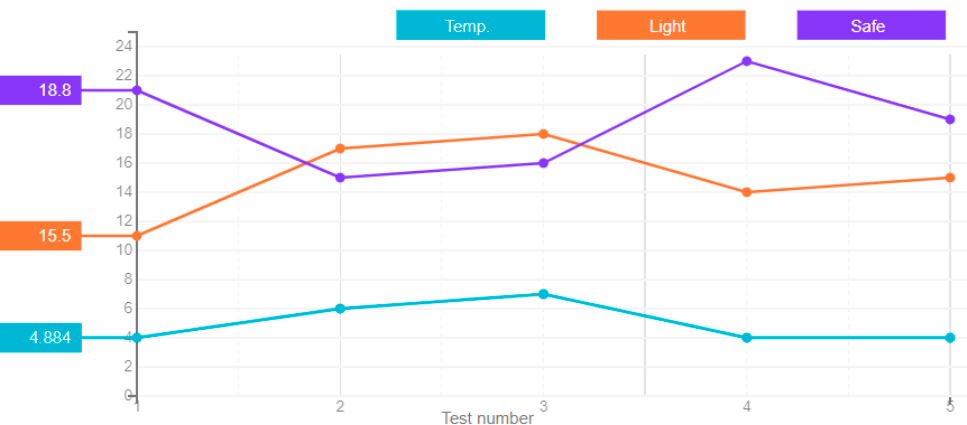
Figure 4. A chart of the feedforward neural network’s error value.